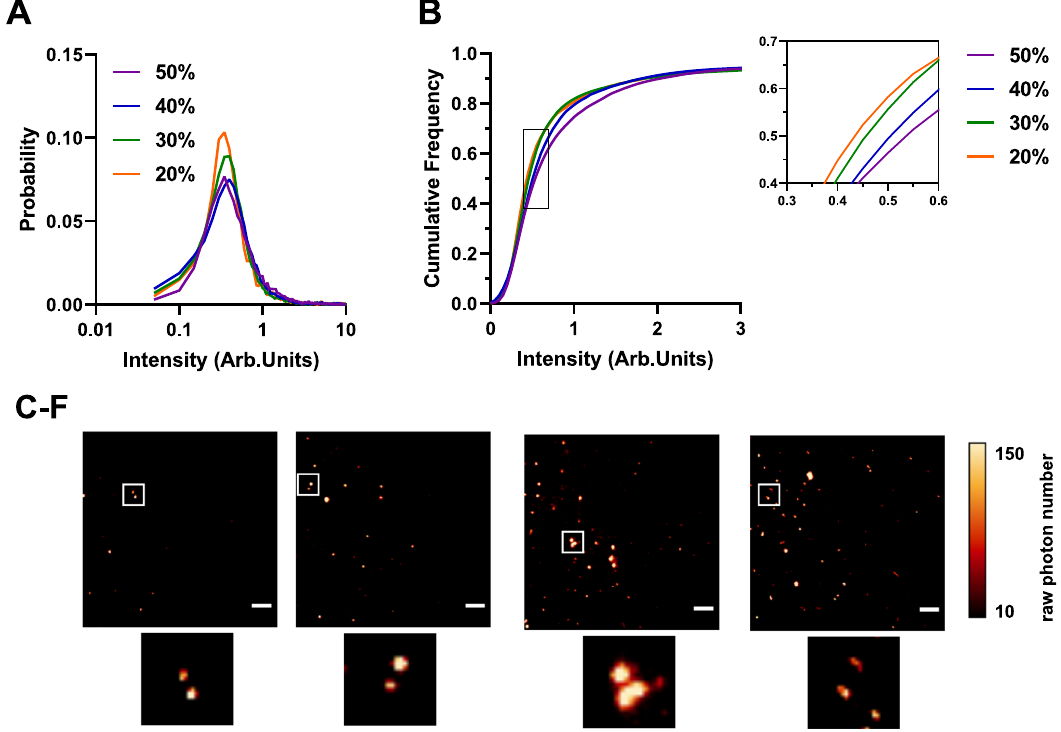
Fig. 2 | Single-molecule characterization of differently sized α -synuclein aggregatesusing thio fl avin T.A Histogram of the thio fl avin T (ThT) fl uorescence intensity distributions for different individual fractions Each histogram is the col- lected data from three independent gradient centrifugations. B Cumulative fre- quency distribution for ThT intensity for 20 – 50% sucrose fractions. Using the Kolmogorov-Smirnovtest,the p -valuesshowthatthecorrespondingintensityfrom eachfractionissigni fi cantlydifferentfromthepreviousonecon fi rminganincrease in size.Kolmogorov-Smirnov test with 20% vs 30% p <0.001,30% vs 40% p <0.001